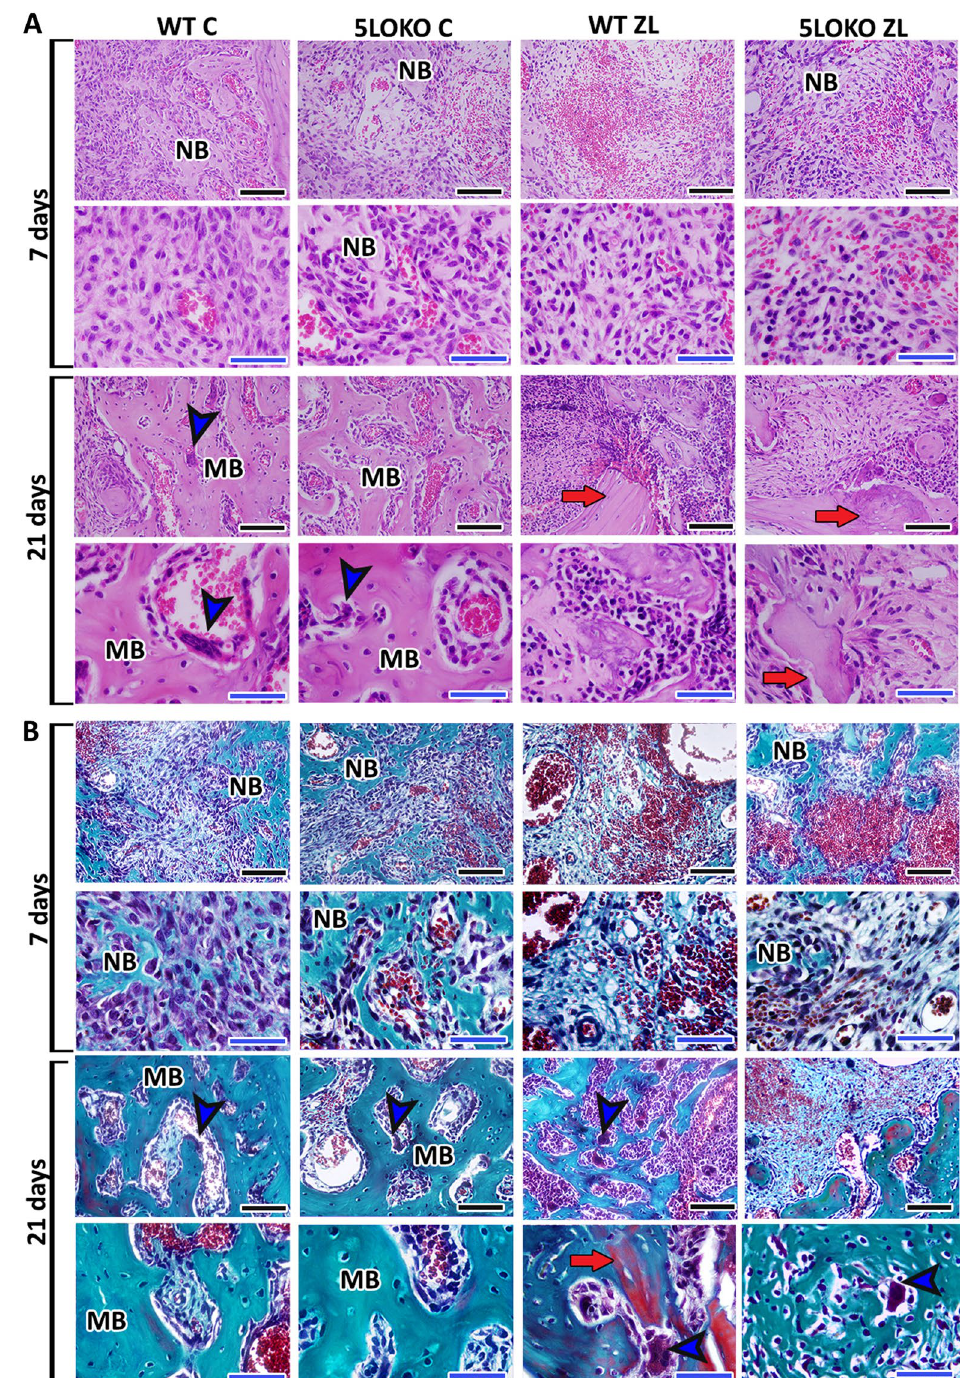
Figure 3. Histopathological analysis of alveolar sockets post tooth extraction from WT vs. 5LOKO mice treated or not with ZL. Aged 129 Sv WT and 5LOKO female mice received IP injections of 0.9% saline solution ( C ) or 250 μg/Kg (ZL groups) once a week, and upper right incisor were extracted at 4 weeks of each treatment. Mice were euthanized for maxillary bones removal after 7 days and 21 days post tooth extraction. ( A ) Representative transversal sections are observed throughout days 7 and 21, from the central area of alveolar sockets. Histological slides were stained with HE (A) and modified Goldner trichrome + Alcian blue ( B ). Images were captured at 10 × and 100 × magnification (panels). Black scale bar = 100 µm, Blue scale bar 50 µm. NB New bone formation, BC Blood clot, MB mature remodeling trabeculae, blue arrowheads = osteoclasts; red arrows = non-viable old